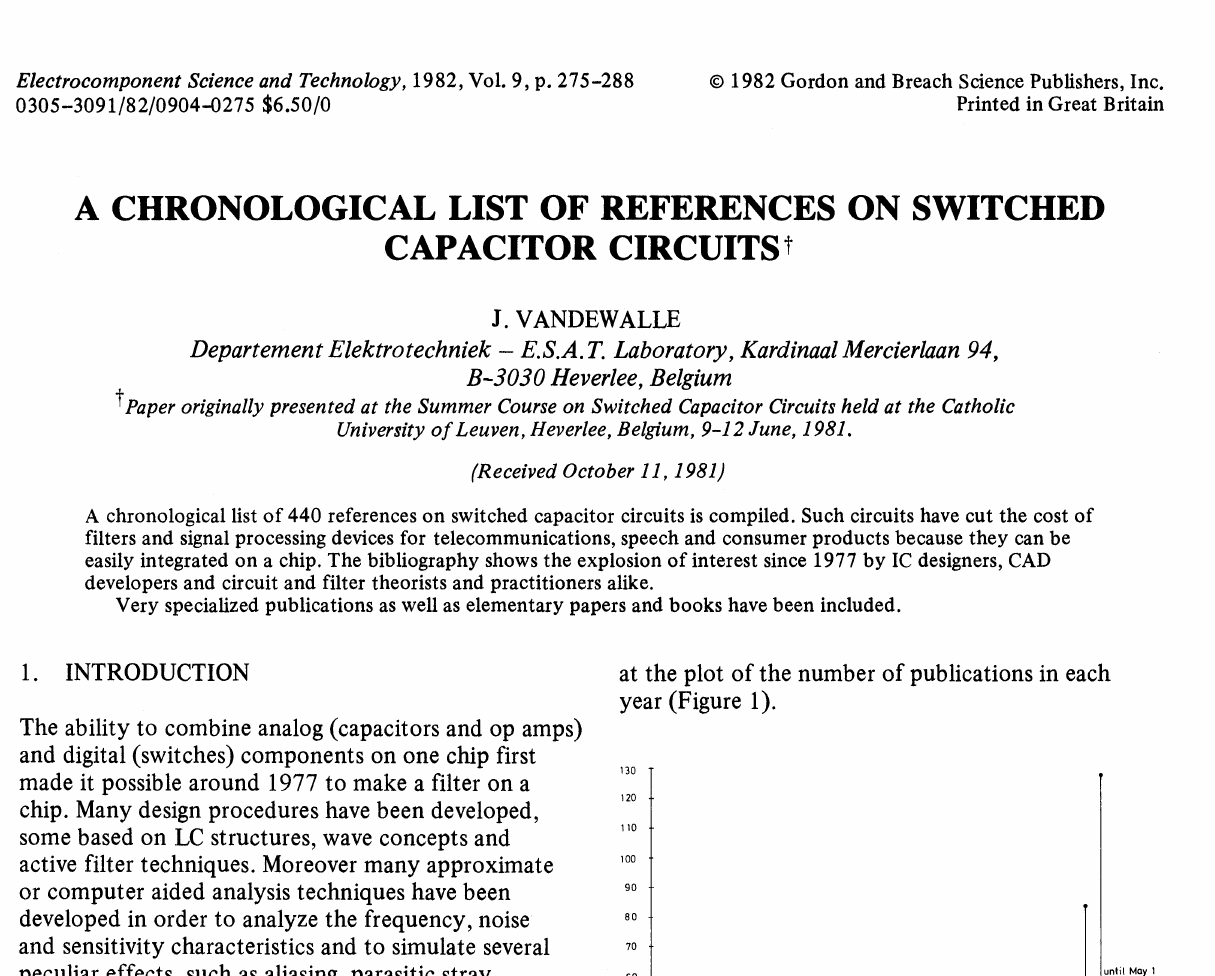
Number of publications on switched capacitor circuits from 1950 to